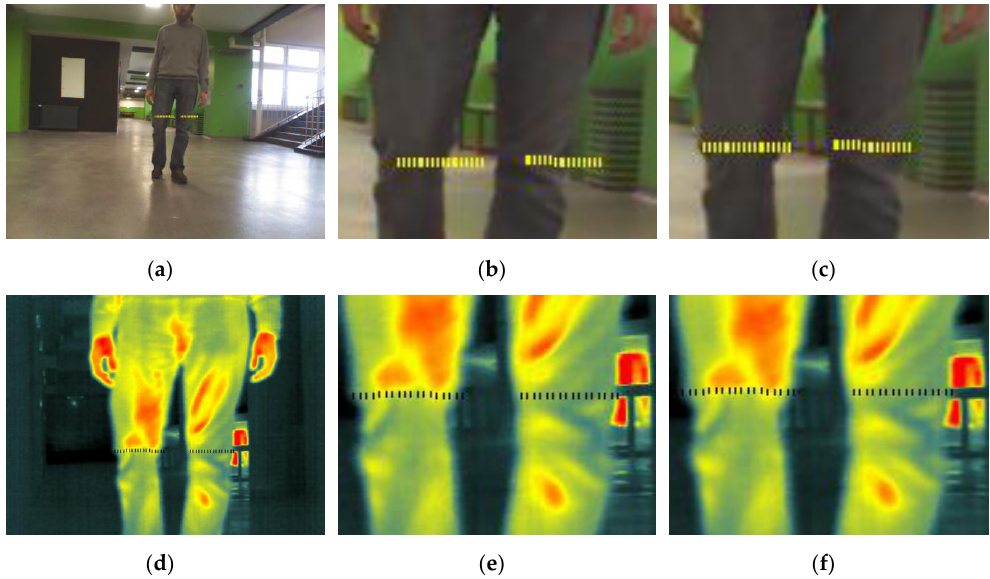
Figure 6. Images before and after the calibration process: ( a , d ) before calibration of vision camera and laser, ( b , e ) zoom of the legs region before calibration, and ( c , f ) zoom of the legs region after calibration.